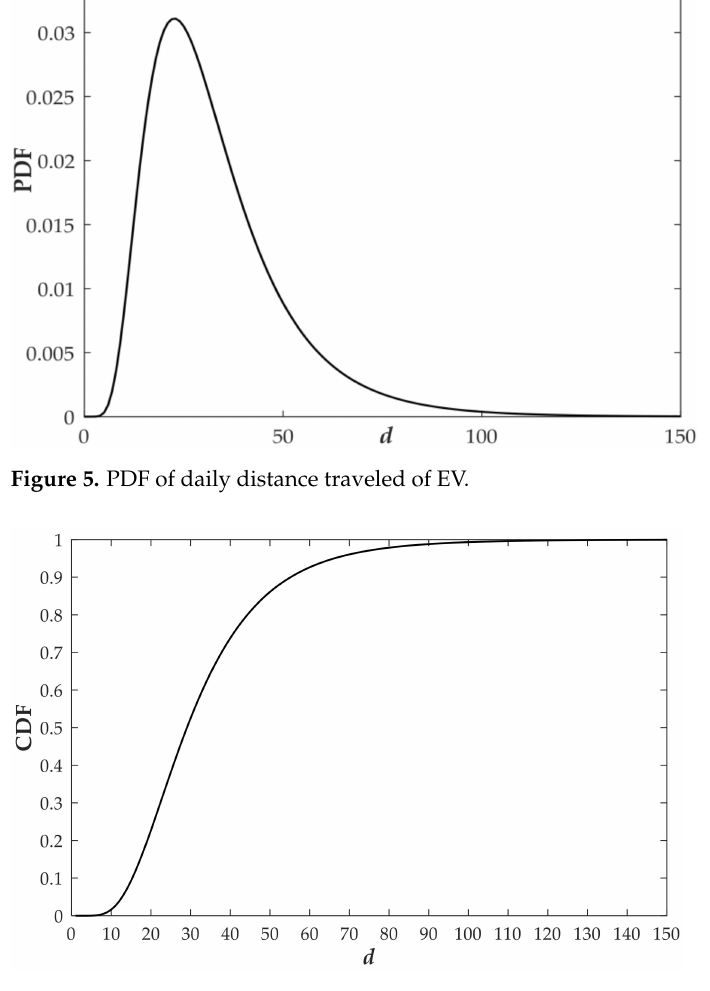
Figure 6. CDF of daily distance traveled of an